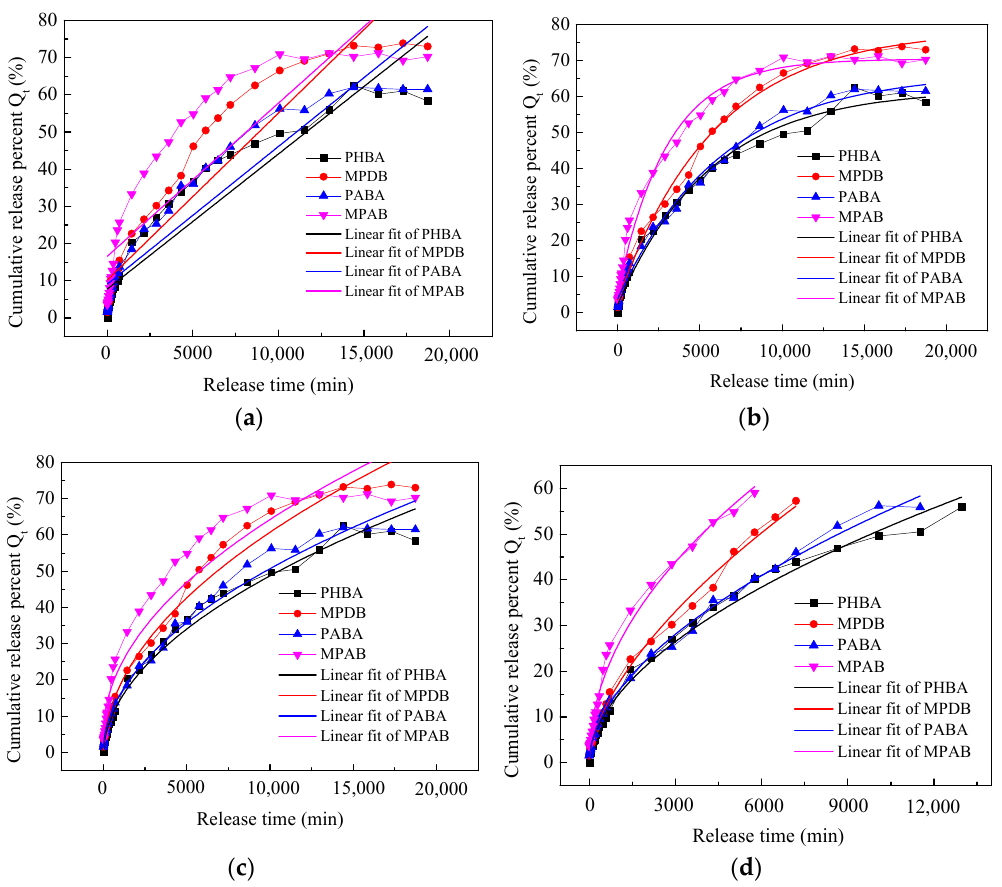
Figure 2. The release kinetics model fitting curves of PHBA, MPDB, PABA, and MPAB drugs: ( a ) zero-order release kinetics; ( b ) first-order kinetics model; ( c ) Higuchi model; and ( d ) Korsmeyer– Peppas model. Table 1. The release kinetics model fi tt ing parameters of PHBA, MPDB, PABA, and MPAB drugs.